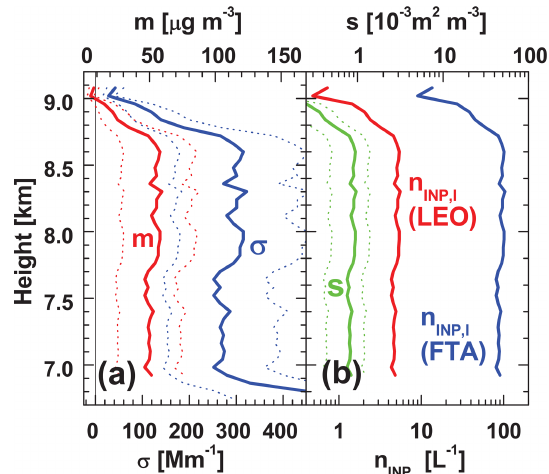
Figure 15. CALIPSO smoke observation in the stratosphere over North and South Dakota on 13 September 2020 in terms of (a) particle extinction coefficient σ and mass concentration m and (b) INP concentration estimates n INP , I for T = − 40 ◦ C, (cid:49)a w = 0 . 2, and two different organic substances (leonardite, LEO, and free- tropospheric smoke aerosol, FTA; see Table 2). The lidar-derived input parameter is the shown surface area concentration s . The CALIPSO aerosol backscatter coefficients were downloaded and averaged over the range from 45–48.5 ◦ N (CALIPSO, 2020b) and then multiplied with 70sr to obtain the extinction coefficients. Error margins (thin dotted lines) show the uncertainties in σ , m , and s as given in Table 4 (fifth